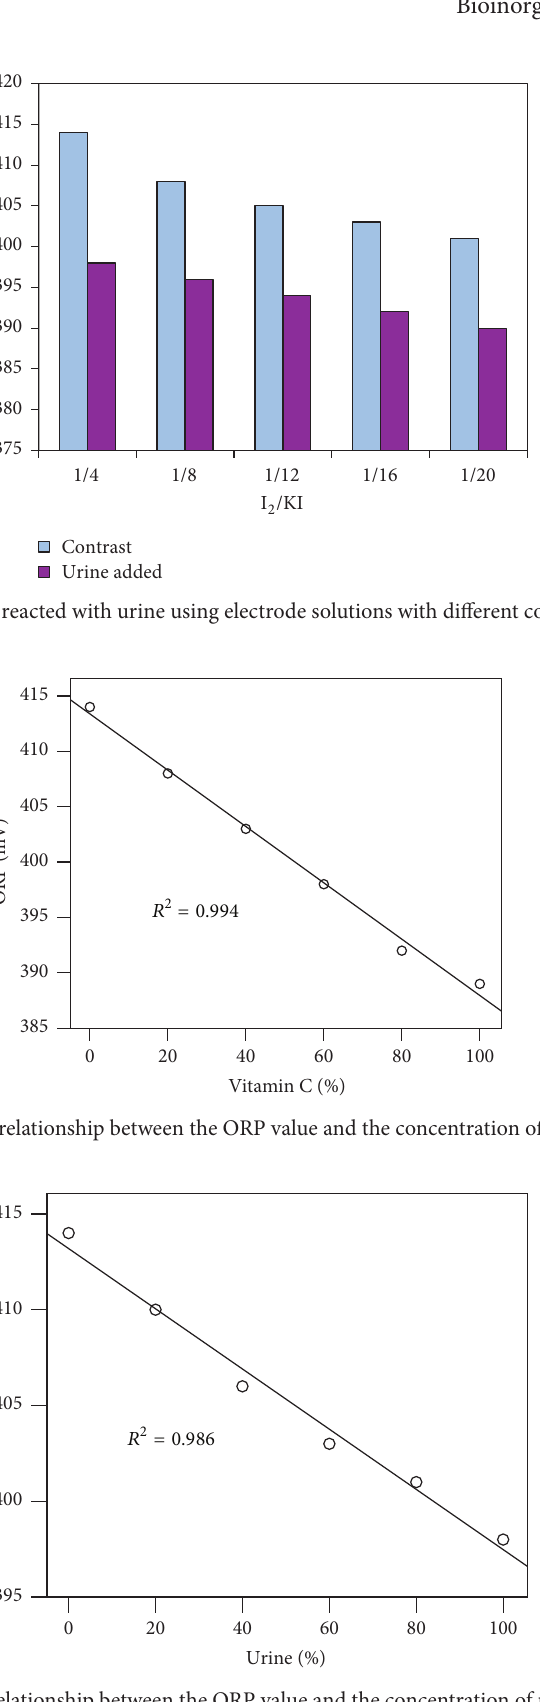
Figure 5: Liner relationship between the ORP value and the concentration of mixed